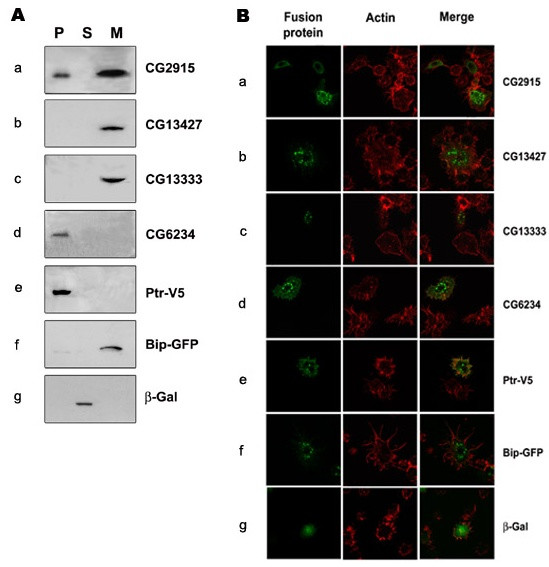
Subcellular localization of uncharacterized proteins. S2R+ cells were transiently transfected with plasmids expressing tagged CG2915, CG13427 CG1333 and CG6234 recombinant proteins. As controls for secreted, cytoplasmic, and transmembrane proteins, cells were transfected with constructs expressing V5-tagged Bip-GFP, β-Gal and Ptr fusion proteins, respectively. (A) Transfected cells were fractionated to obtain high-speed pellets (P) and supernatants (S). Equivalent volumes of cell fractions plus the medium in which cells were grown (M) were loaded on the gel and subjected to western blot analysis with anti-V5 (panels a and b and d to g) or anti-myc (panel c). (B) Transfected S2R+ cells were stained with anti-V5 (green in a and b and d to g) or anti-myc (green in c) and phalloidin to visualize actin (red in panels a to g).